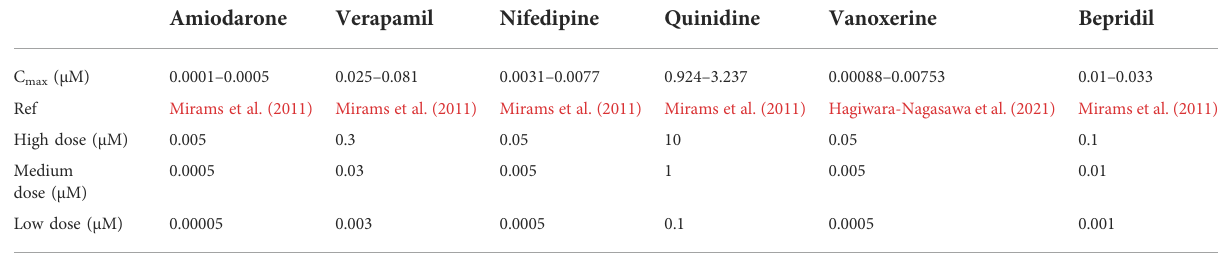
TABLE 3 C max and experimental dose allocation for six multi-channel